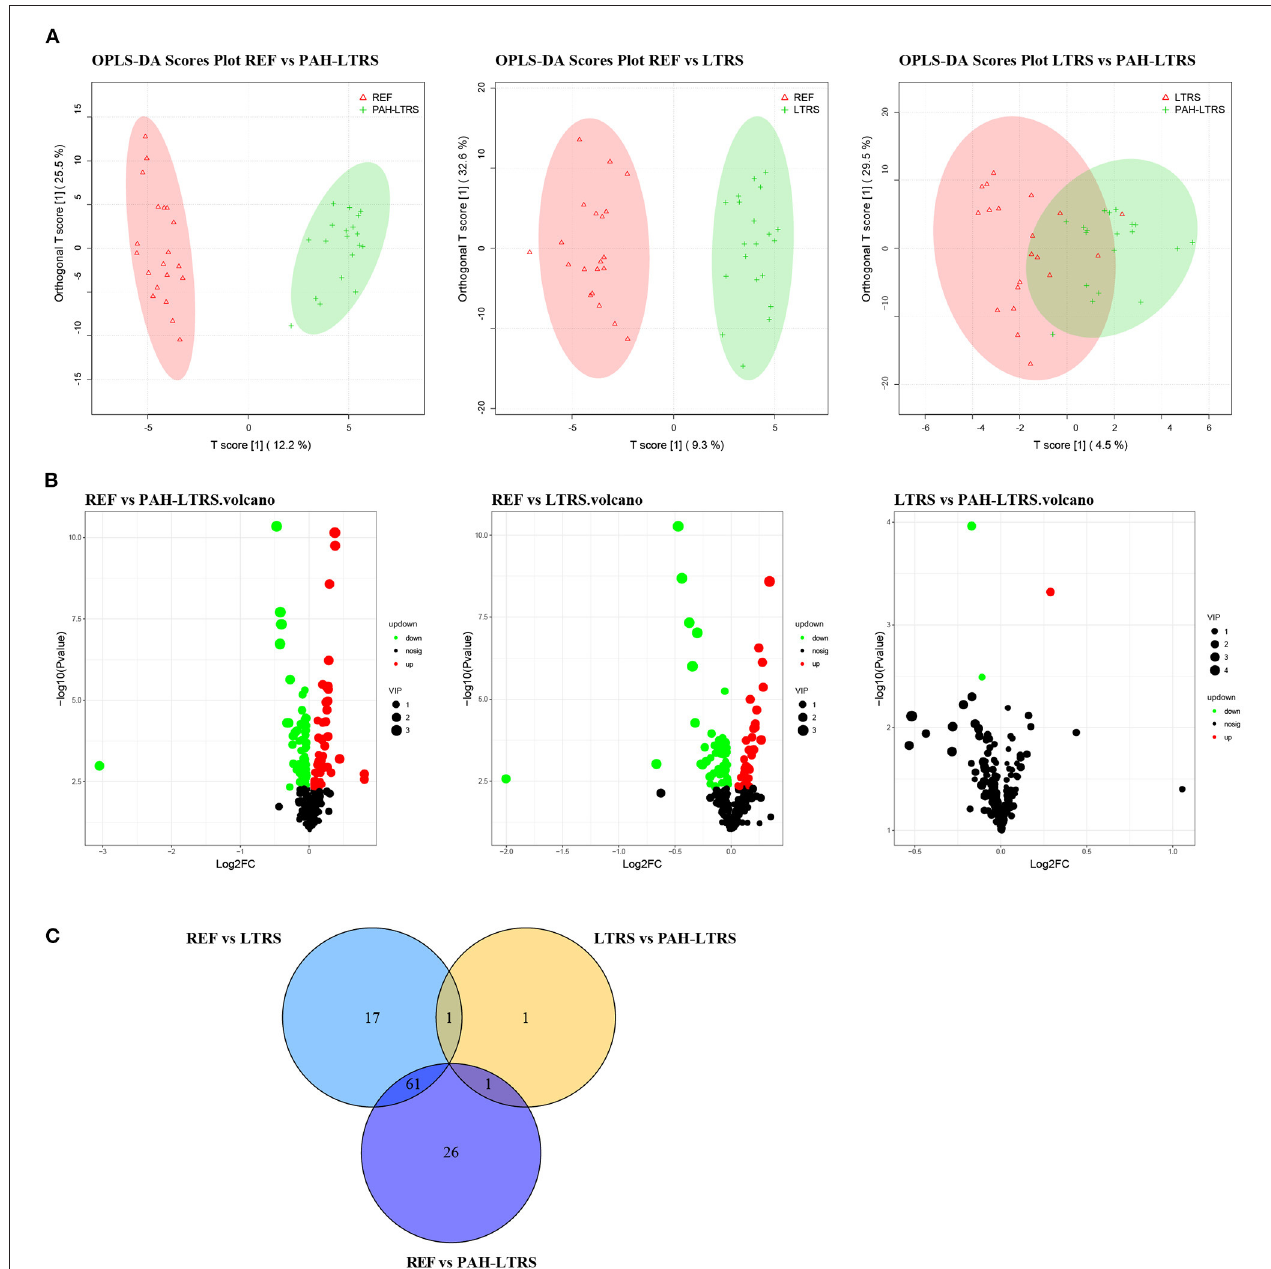
FIGURE 4 | Differential lung metabolites between different groups. (A) OPLS-DA was used to discriminate between different groups. (B) volcano plot of the differential metabolisms for any two groups (VIP > 1, P < 0.05). (C) Venn diagram showed the altered metabolites overlap among three pair of comparisions. PAH-LTRS, patients with pulmonary arterial hypertension associated with Left-to-Right shunt ( n = 19); REF, healthy reference ( n = 20); LTRS, patients with Left-to-Right shunts but without PAH ( n =